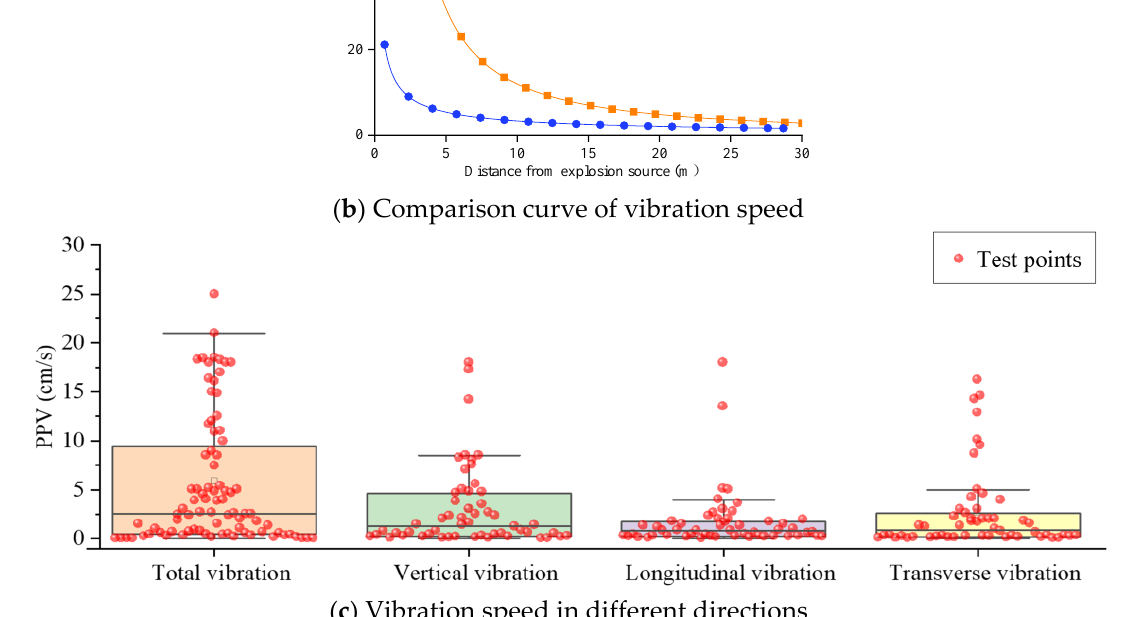
Figure 23. Vibration velocity characteristics of CDPTB.